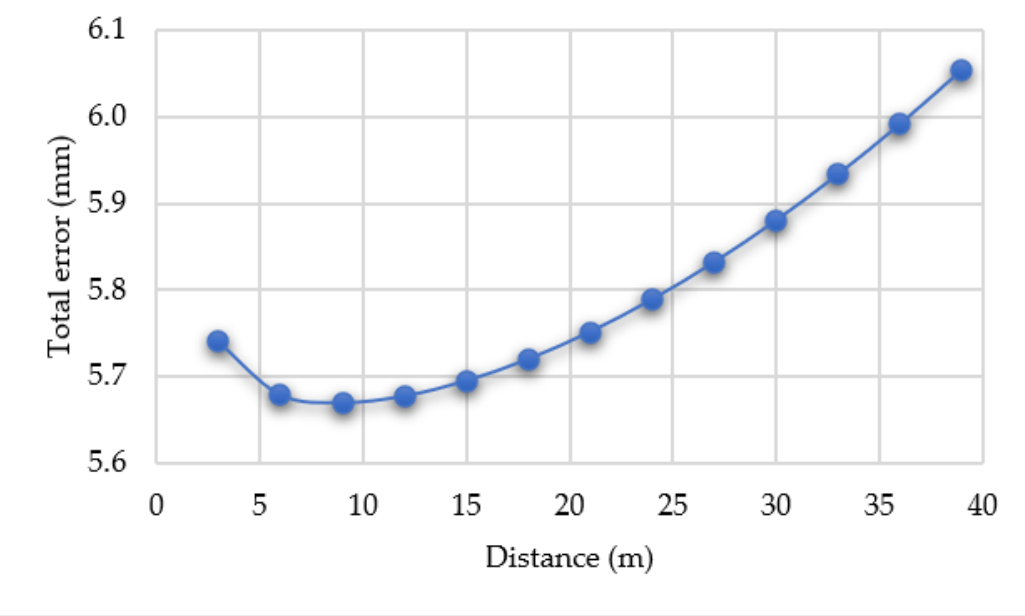
Figure 10. The resulting error graph. The obtained errors will be used for the comparison analysis in Section